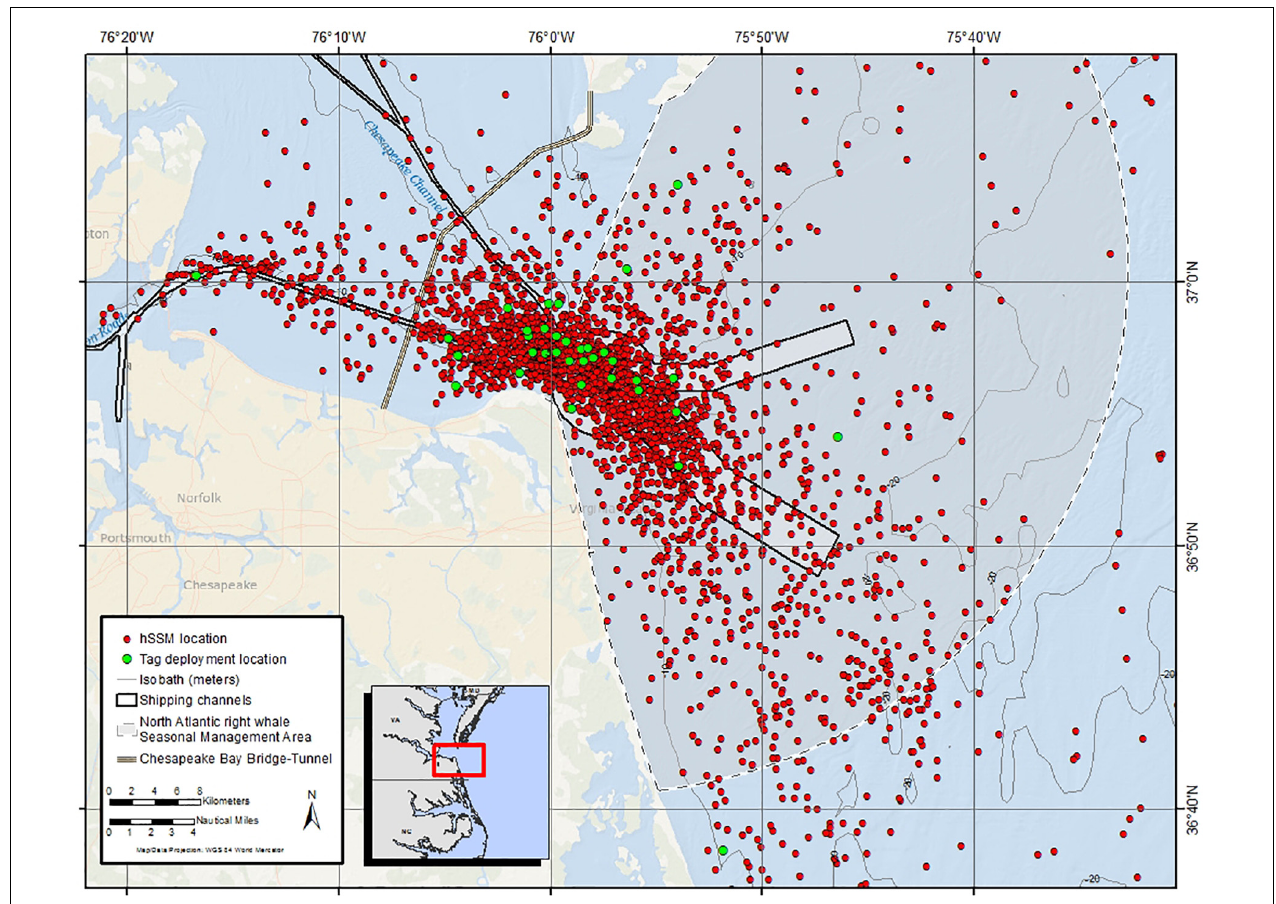
FIGURE 4 | All hierarchical state-space model (hSSM) locations (red dots) in the immediate vicinity of the shipping channels at the mouth of the Chesapeake Bay from 33 satellite tagged humpback whales included in the hSSM. Green dots show tag deployment locations from all 35 tagged